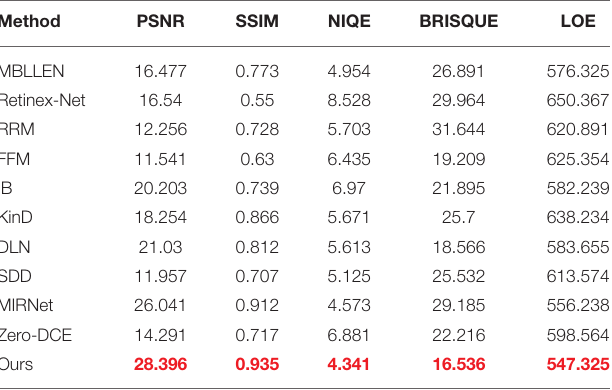
TABLE 2 | Quantitative comparison with state-of-the-art methods on the LOL dataset.